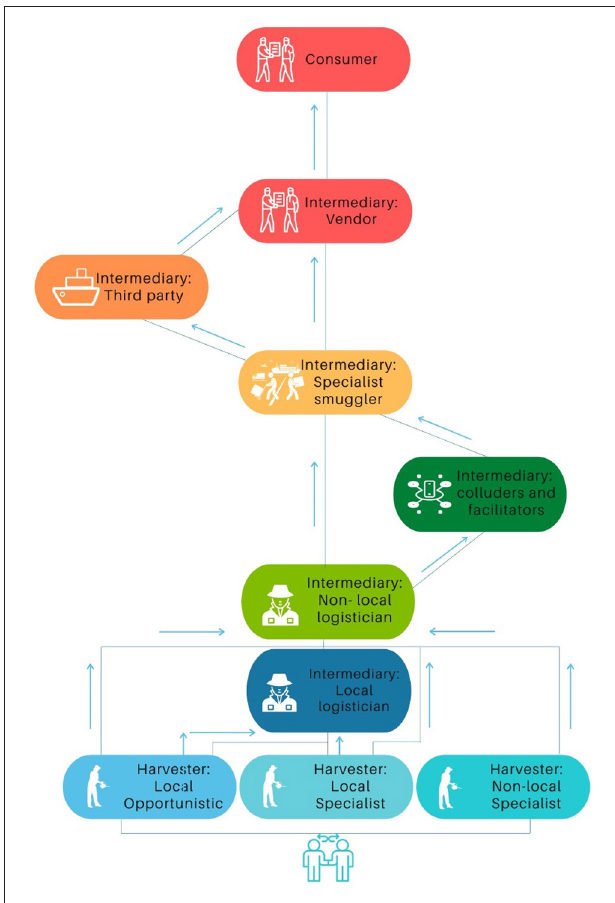
FIGURE 3 | Flow chart showing Philippine pangolin trade chains and actors.